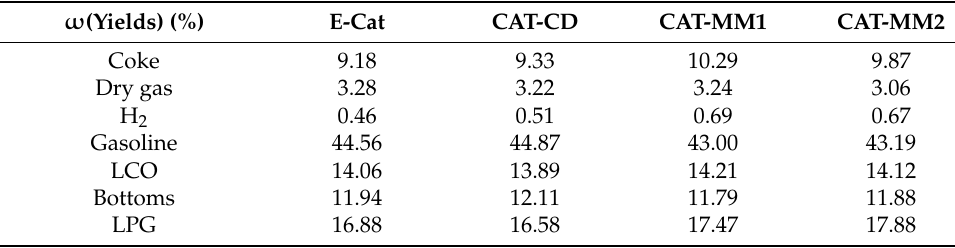
Table 2. Product yields at 74 wt.% conversion.